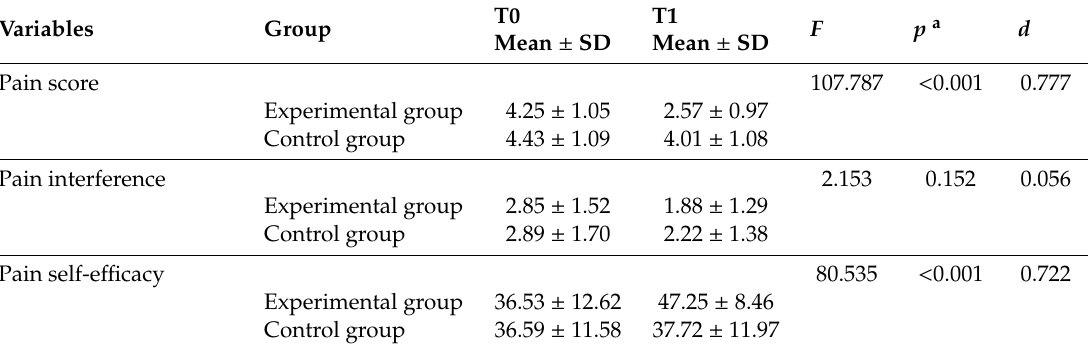
Table 2. Pre-post outcome